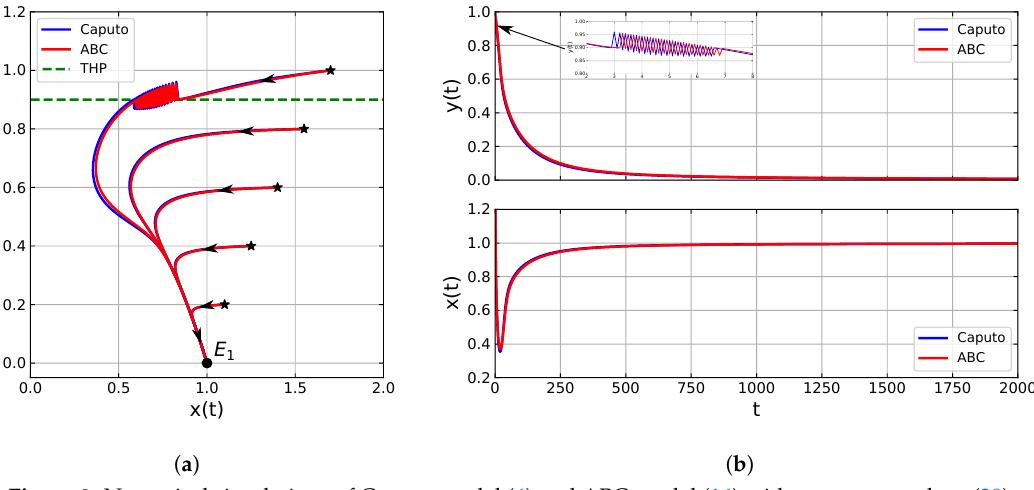
Figure 2. Numerical simulations of Caputo model (6) and ABC model (16) with parameter values (29) and n = 0.1: Figure ( a ) phase portrait; and Figure ( b ) time